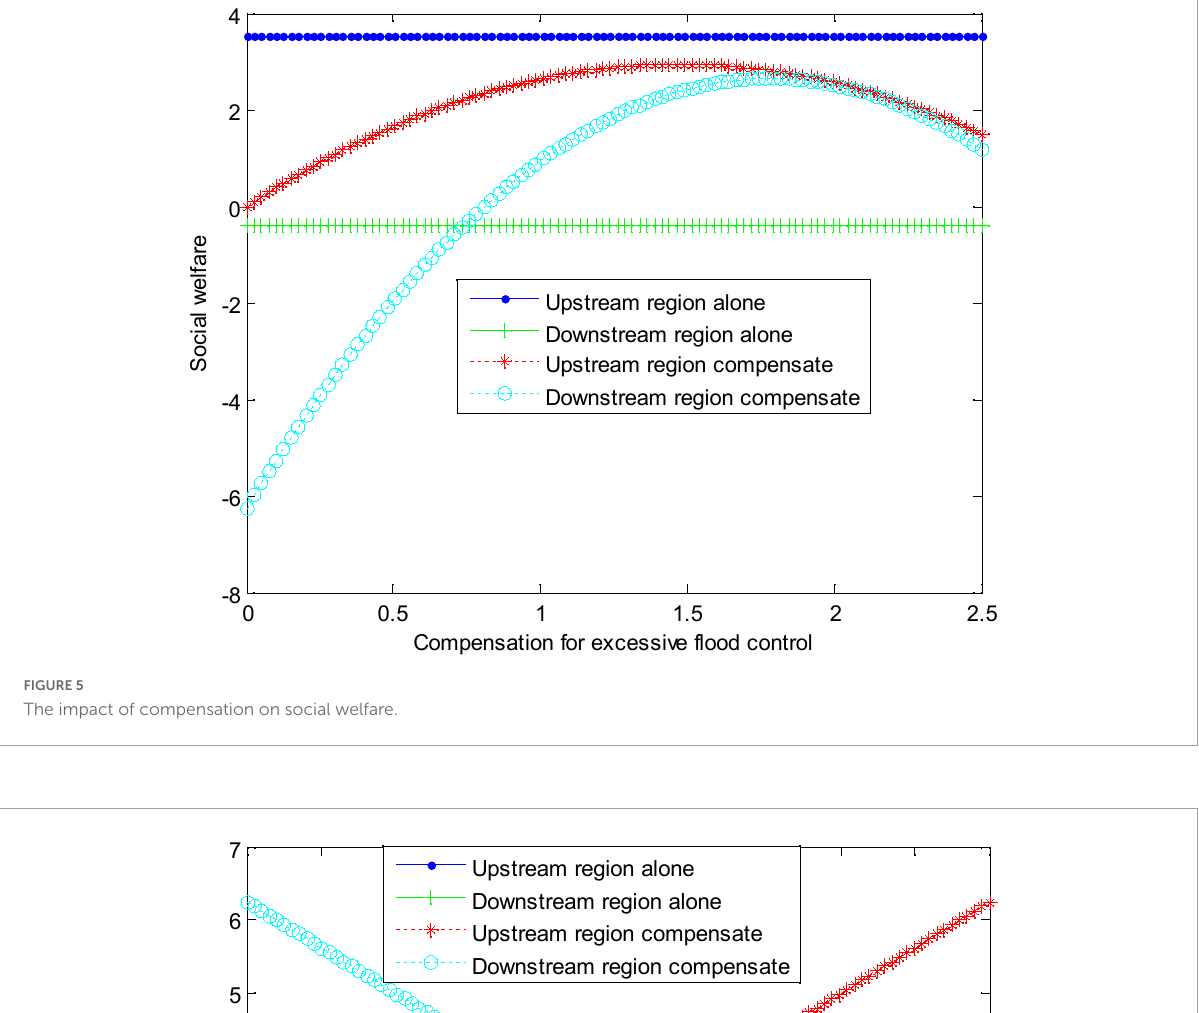
FIGURE5 The impact of compensation on social welfare.